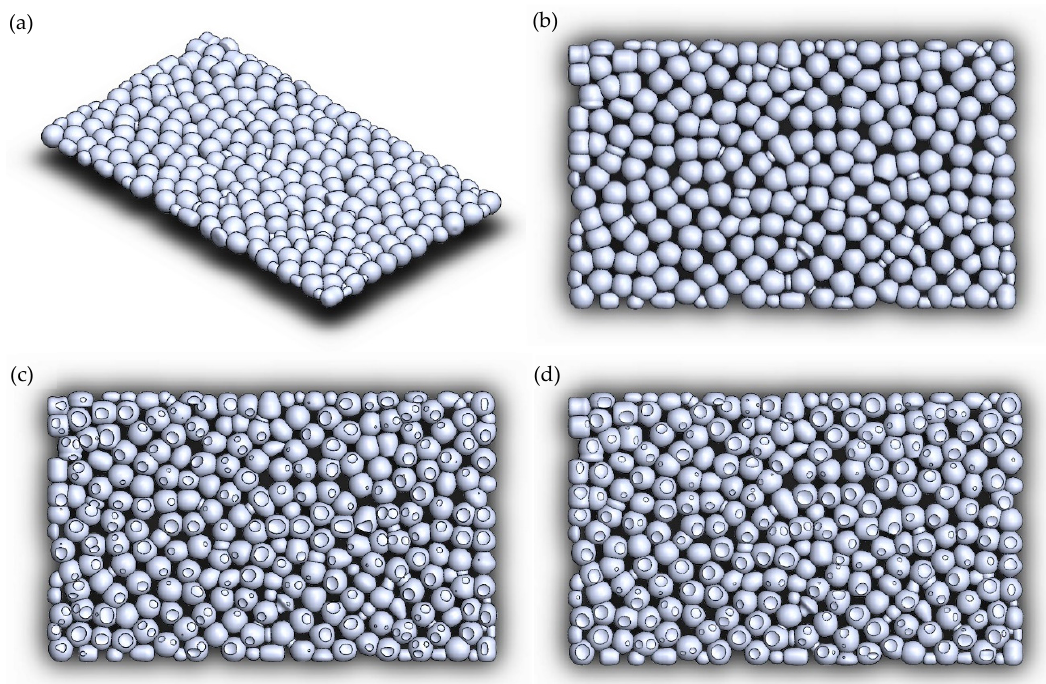
Figure 1. Clockwise from top left; ( a ) An orthogonal view of the first layer of the artificial riverbed measuring 300 mm wide, 500 mm long, and 28 mm thick, on average; ( b ) The plan view of the first layer of the artificial riverbed, highlighting how particle geometry is positioned to form voids; ( c ) The plan view of the second layer of the artificial riverbed, highlighting the cavities left by the third layer; ( d ) The plan view of the fourth layer of the artificial riverbed, highlighting the cavities left by the fifth layer.